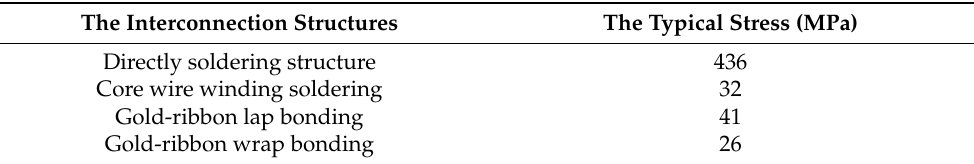
Table 3. Stress simulation results of the above structures.